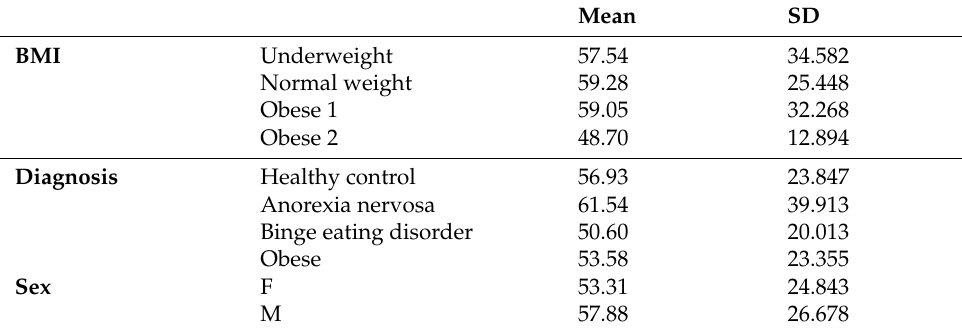
Table 2. Nesfatin-1 plasma levels